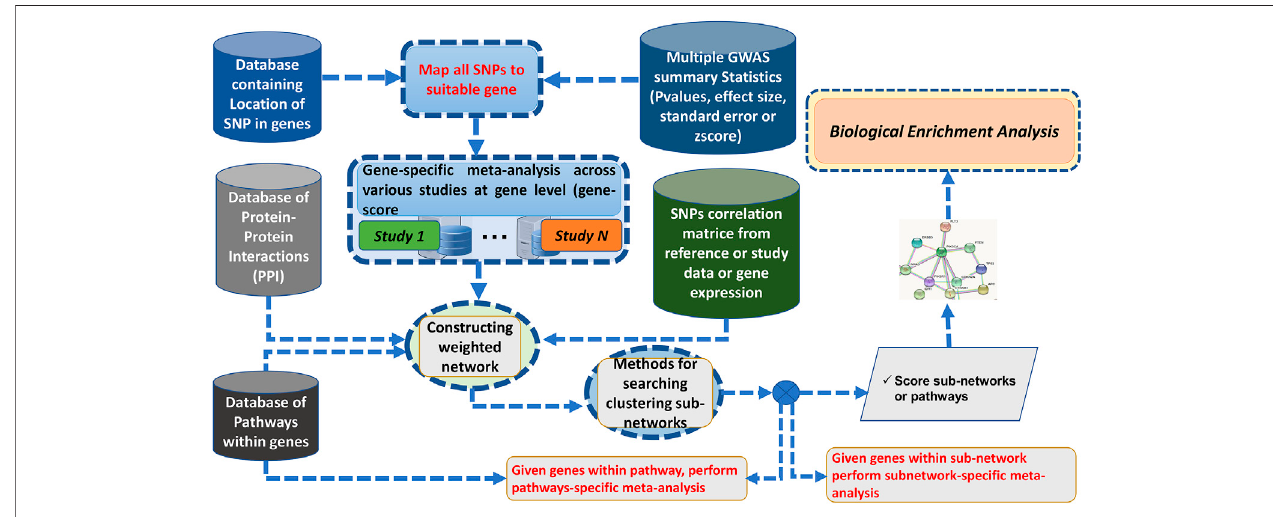
FIGURE 1 | Flowchart of